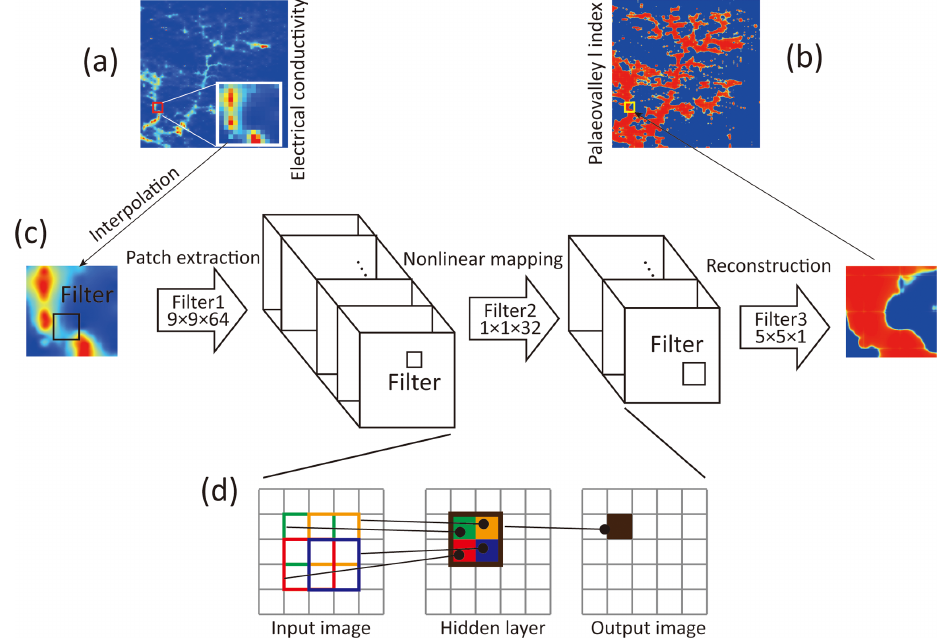
Figure 3. Algorithm of converting (a) low-resolution EC image to (b) high-resolution paleovalley image based on (c) the super-resolution convolutional neural network. (d) Convolutional processes of data from an input image to an output image by a filter with a size of 2, moving through the input image 1 pixel at the